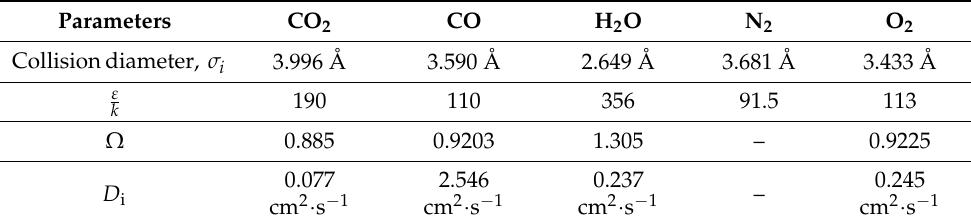
Table 4. Parametric information about mass